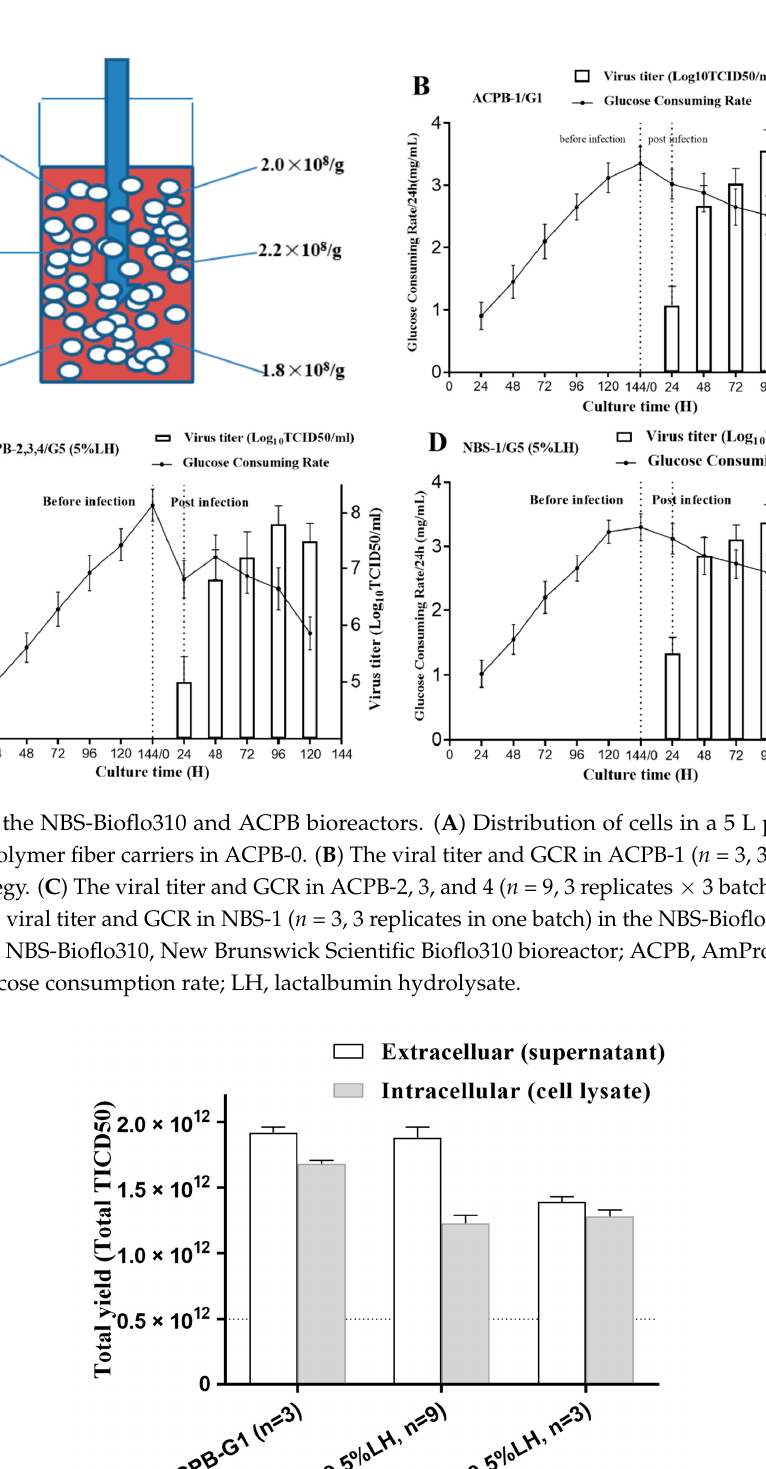
Table 1. Residual BSA of the harvested supernatants at 48, 72, 96, and 120 hpi from the ACPB and NBS-Bioflo310 bioreactors. BSA, bovine serum albumin; hpi, hours post-infection; ACPB, AmPro- tein Current perfusion bioreactor; NBS-Bioflo310; Bioflo310 from New Brunswick Scientific; LH, lactalbumin hydrolysate. Source/Harvest Time